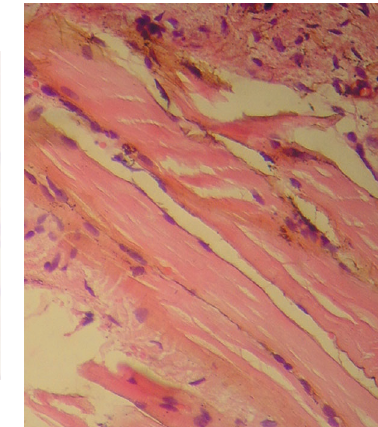
Figure 2- Epithelial acanthosis and brownish-black pigment deposits in the submucosal region (arrow) (Hematoxylin and eosin, ×100)